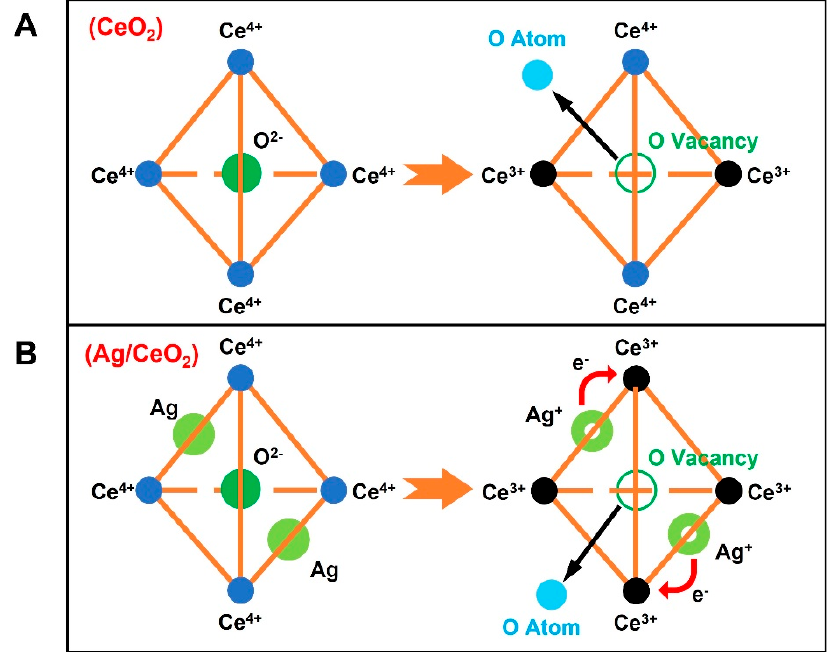
Figure 7. The schematic diagram of crystal structures of pure CeO 2 ( A ) and the prepared Ag/CeO 2 nanocomposite ( B ), respectively. Reprinted with permission from Ref. [60].